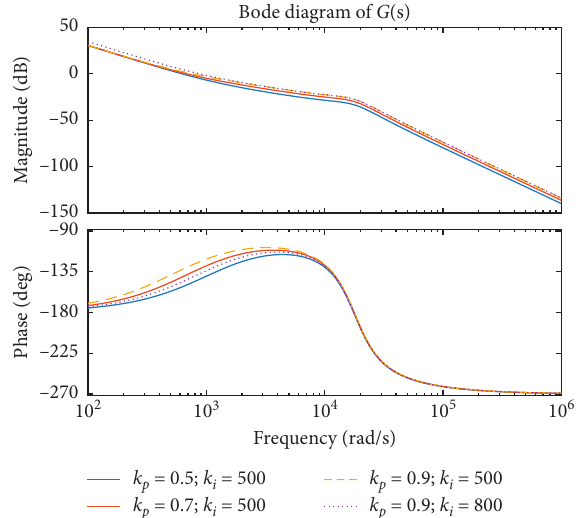
i and K p , the system current is in the